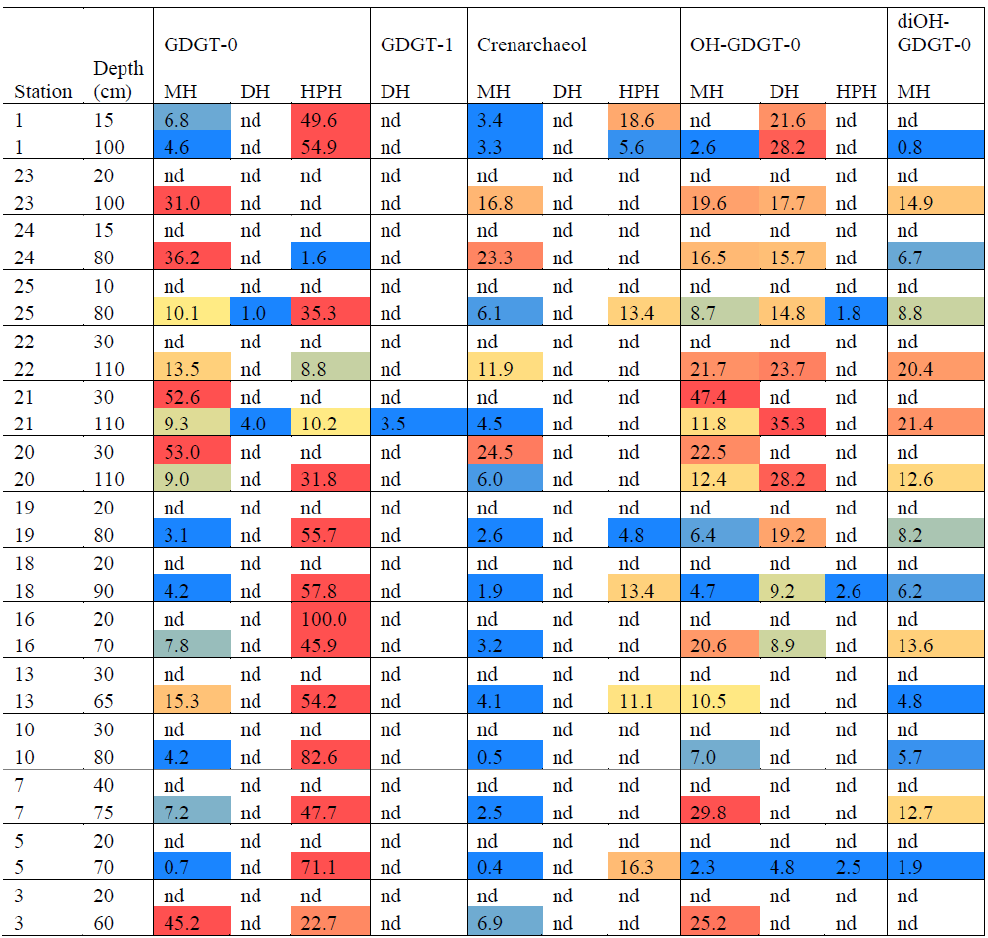
Table 4. Relative abundances (%) and heat map of IPLs identified in Scotia Sea. Relative abundances > 30% indicated in red, low